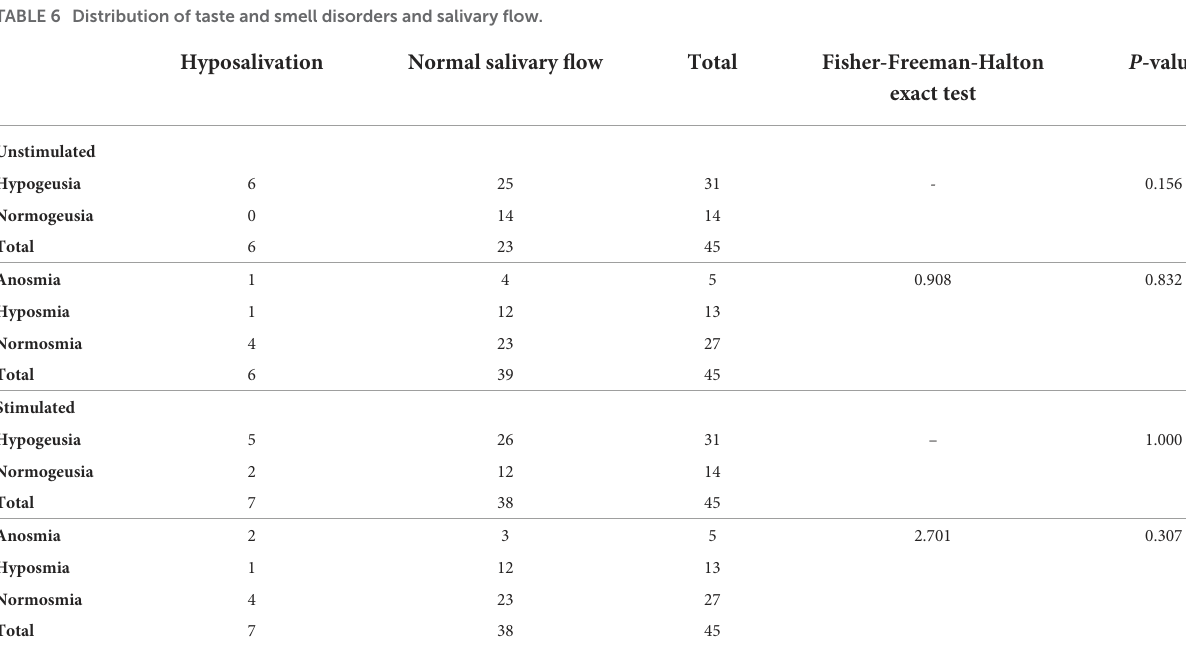
TABLE 6 Distribution of taste and smell disorders and salivary